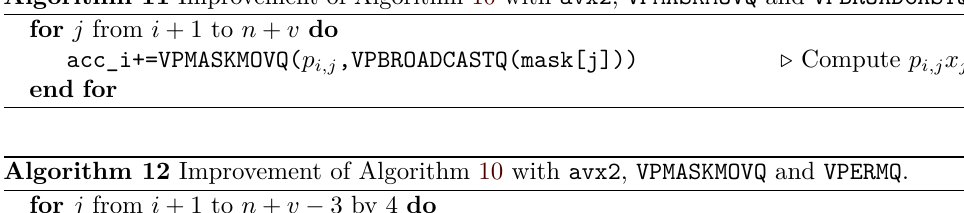
Algorithm 12 Improvement of Algorithm 10 with avx2 , VPMASKMOVQ and VPERMQ